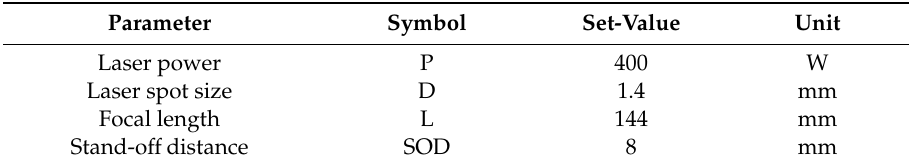
Table 2. Process parameters that were used.